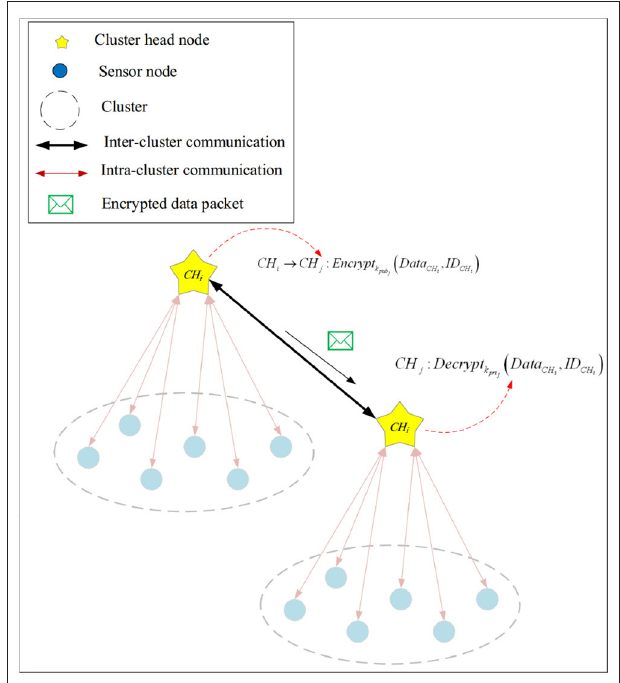
FIGURE 6 | Secure inter-cluster